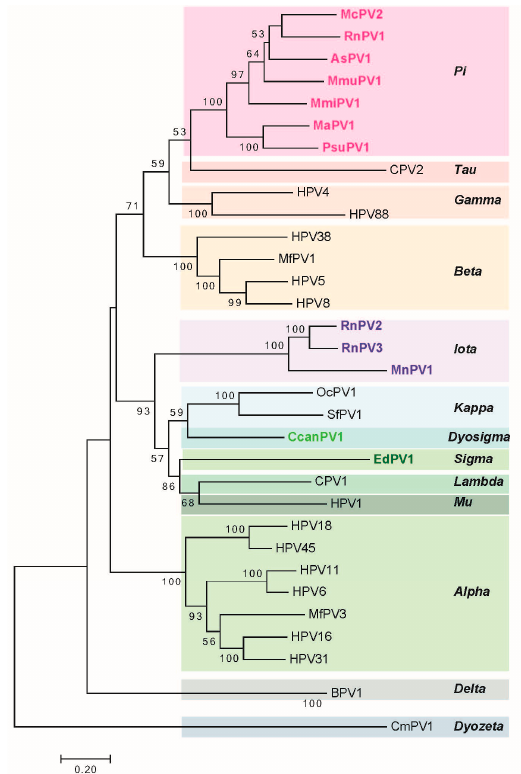
Figure 2. Phylogenetic analysis of rodent PVs. Phylogenetic tree construction of rodent PVs was performed on the basis of L1 nucleotide sequences as per the standard criteria previously set for PV classification [72]. The evolutionary history was inferred by using the Maximum Likelihood method based on the General Time Reversible model, and the tree with the highest log likelihood ( − 31,759.0931) is shown. The percentage of trees in which the associated taxa clustered together is shown next to the branches. Values less than 50% are not shown. Initial tree for the heuristic search was obtained automatically by applying Neighbor-Join and BioNJ algorithms to a matrix of pairwise distances estimated using the Maximum Composite Likelihood (MCL) approach and then selecting the topology with superior log likelihood value. A discrete Gamma distribution was used to model evolutionary rate differences among sites (5 categories (+G, parameter = 0.9374)). The rate variation model allowed for some sites to be evolutionarily invariable (9.1152% sites). The tree is drawn to scale with branch lengths measured in the number of substitutions per site. All positions containing gaps and missing data were eliminated. There were a total of 1311 positions in the final dataset. Evolutionary analyses were conducted in MEGA7 (Version 7.0.21, Pensylvania State University, Hershey, PA, USA) [73]. In this small-scale phylogenetic analysis 33 papillomaviruses that represent prototype papillomaviruses in each clade were chosen for the analysis. For the most recent complete phylogenetic analysis of all papillomavirus species, the reader is referred to de Villiers, (2013)